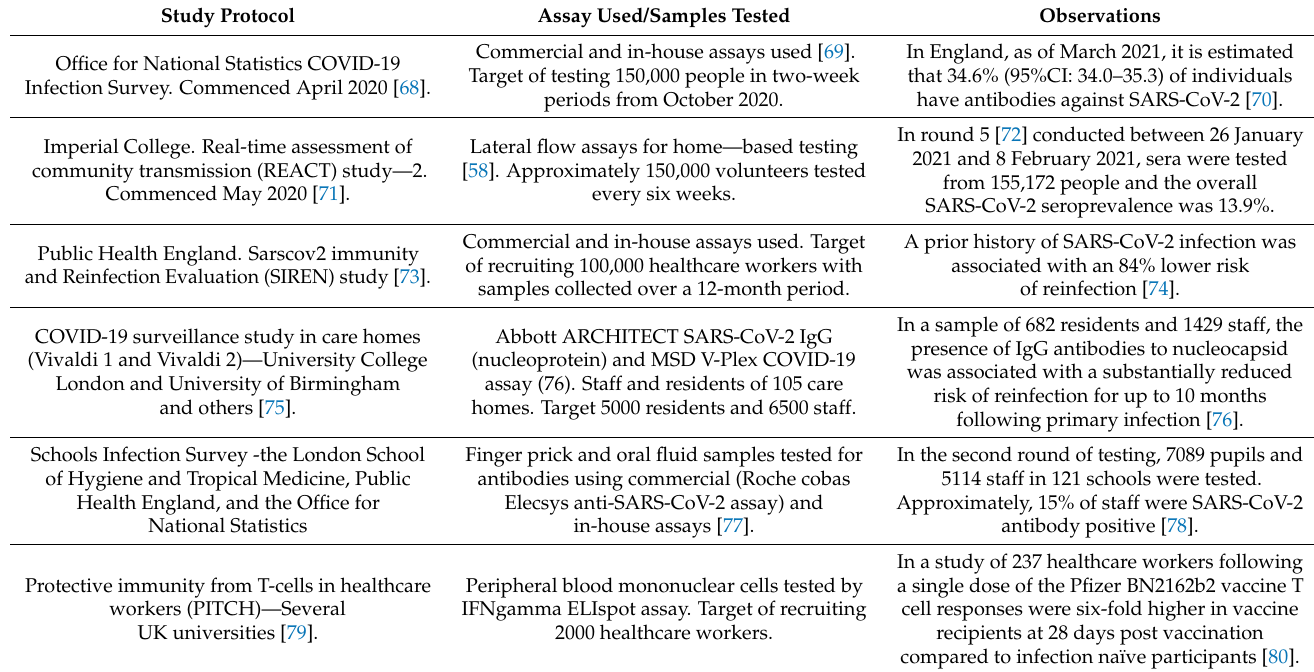
Table 3. Examples of SARS-CoV-2 antibody population surveys undertaken in England